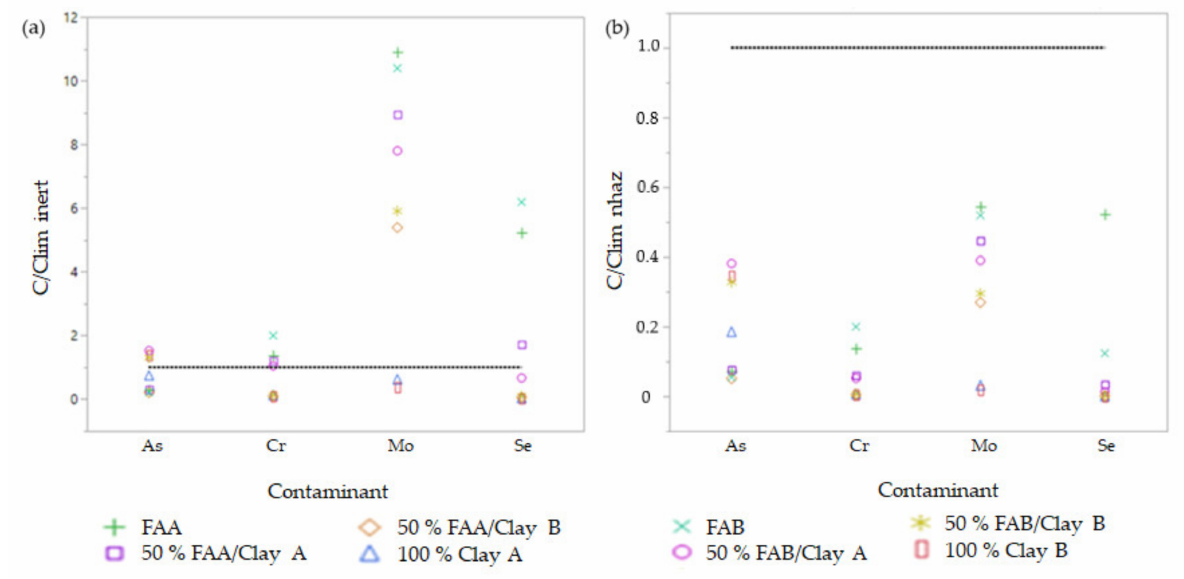
Figure 6. Concentration of contaminants of fly ash/clay bricks regarding the inert waste landfill limits ( a ) and the non-hazardous waste landfill limits ( b ) according to Decision